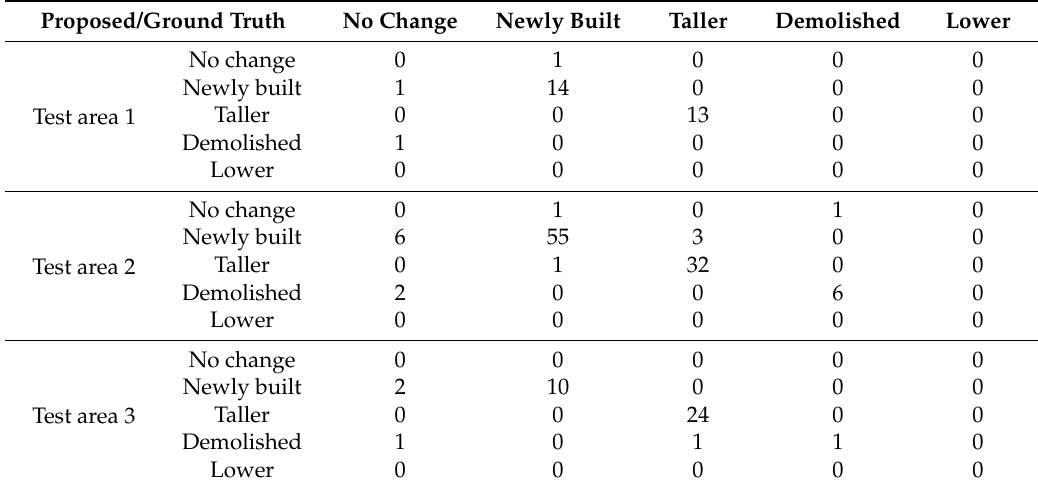
Table 4. Confusion matrix of the building change detection in the three test areas.